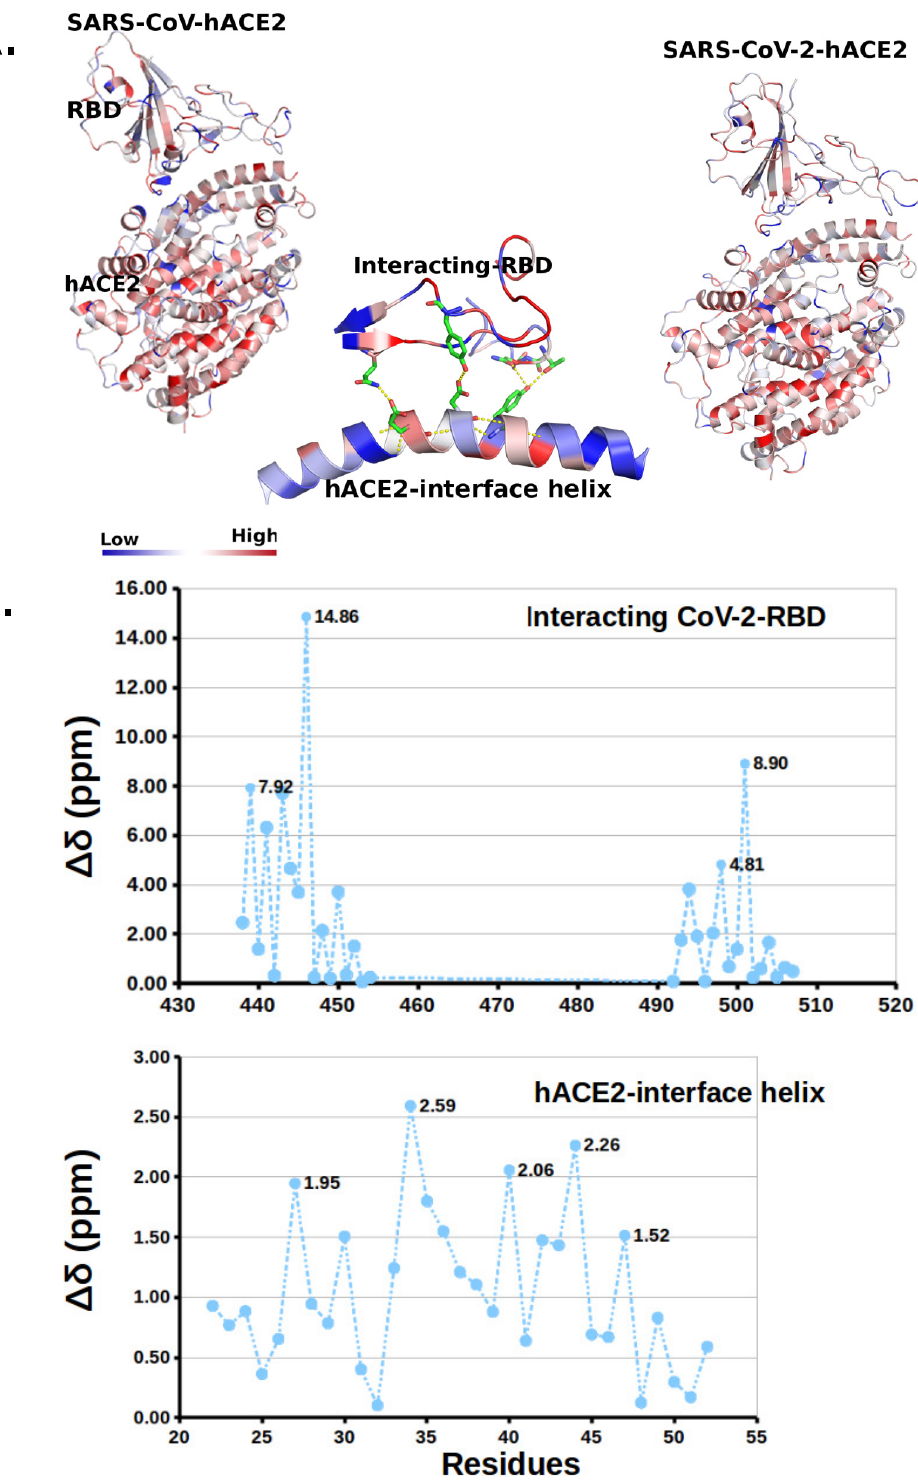
Figure 2. 13 C Chemical shifts δ caused by interface interactions between hACE2 and RBD. ( A ) Changes in δ for the complexes (top two figures), the middle figure shows the deviation in chemical shifts ( ∆ δ ) at the interface interacting sites. ( B ) Change in ∆ δ observed at H-bond forming residues GLU 35, THR 27 on the hACE2 helices and GLN 493 and TYR 489 on RBD